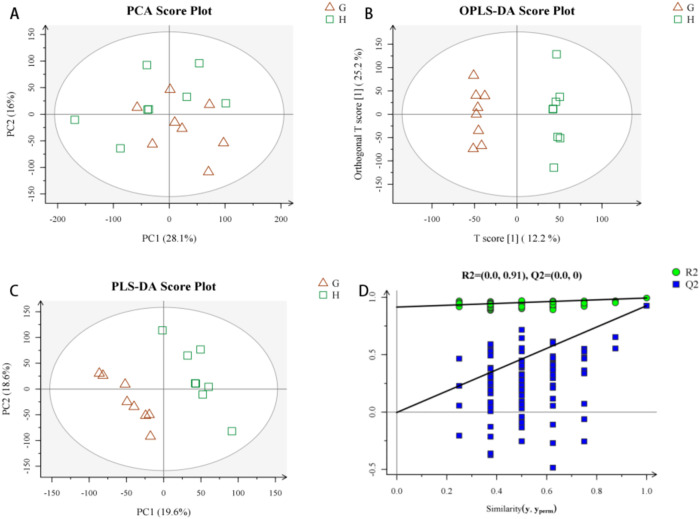
Urine metabolism profile of CAG model rats in positive ion mode.4-A: PCA Scores, 4-B: PLS-DA Scores, 4-C: OPLS-DA Scores, 4-D: Replacement Test of the CAG Model Urine Fit Model in Positive Ion Mode.